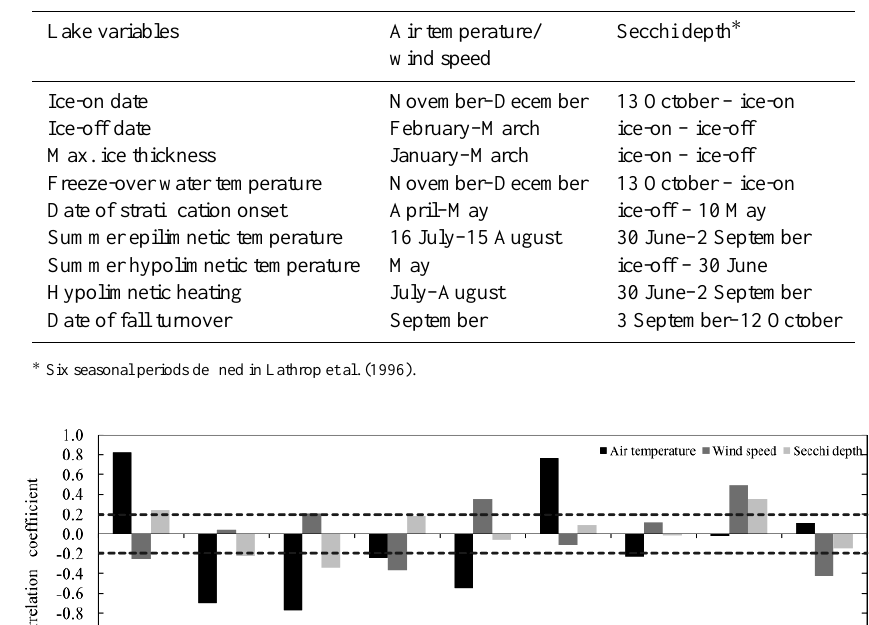
Table 3. Averaging periods for lake drivers used for calculating correlation coefficients of each pair of variables.